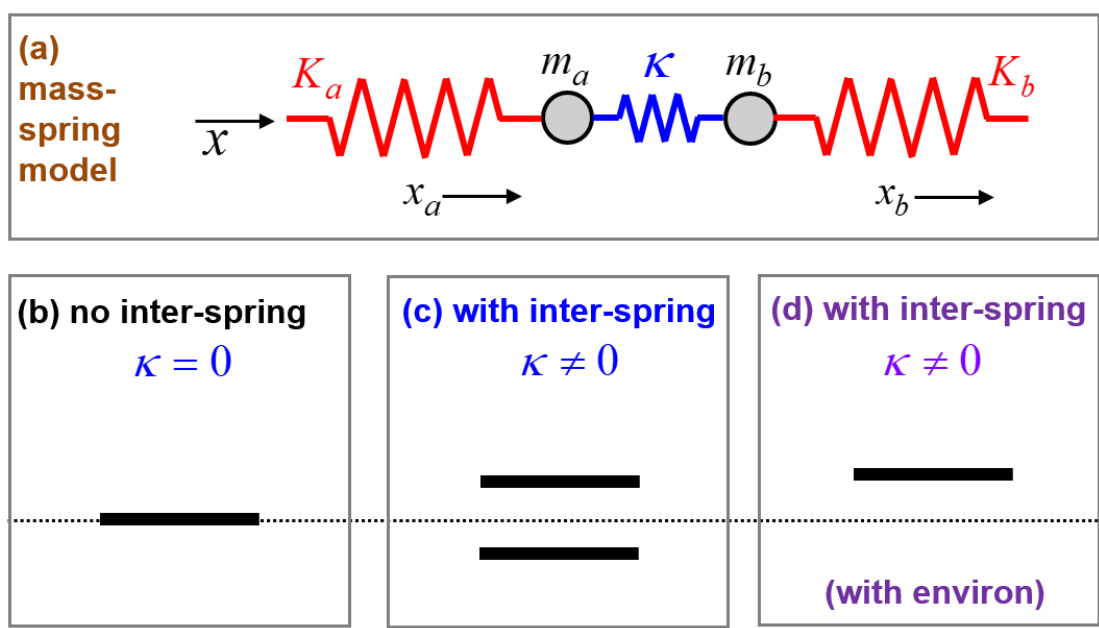
Figure 3. ( a ) A mass-spring system for an identical mass m and an identical spring constant K . The coupling spring constant is given by κ . ( b ) An uncoupled system with κ = 0. ( c ) A coupled system with κ (cid:54) = 0. ( d ) A coupled system with κ (cid:54) = 0 along with other constraints. Here, it is assumed that K > 2 κ ≥ 0 to ensure ( ω ± ) 2 > 0 for a loss-free system for which all frequencies are treated as positive. We encounter another pair (cid:112) m − 1 ( K ± 2 κ ) of a bi-characteristics-like feature. In Figure 3, the horizontal dotted ω ± ≡ √ K / m for line passing through Figure 3b–d denotes the frequency label of ω κ = 0 ≡